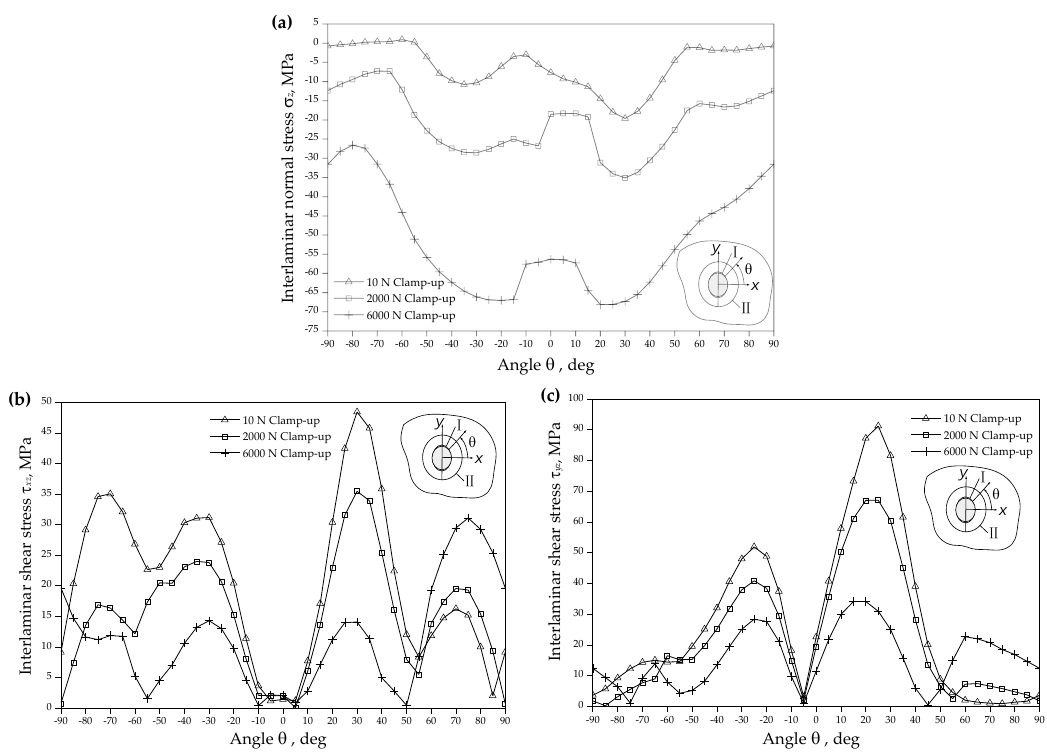
Figure 9. Stress distributions in 0/45 interface at Position I at different clamping forces: ( a ) σ z ; ( b ) τ xz ; ( c ) τ yz